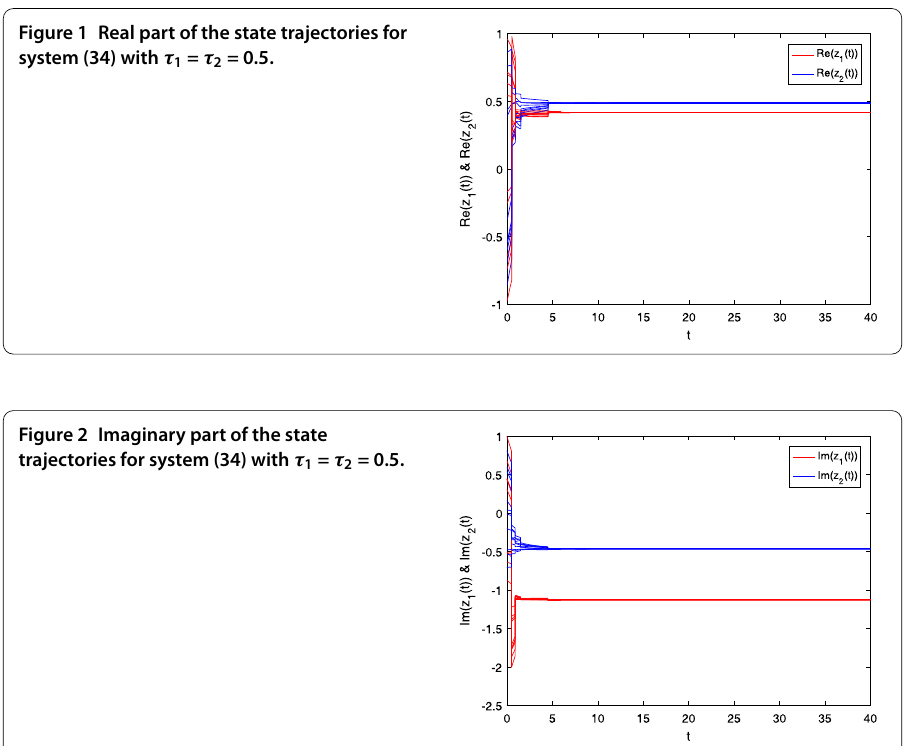
Figure 2 Imaginary part of the state trajectories for system (34) with τ 1 = τ 2 =